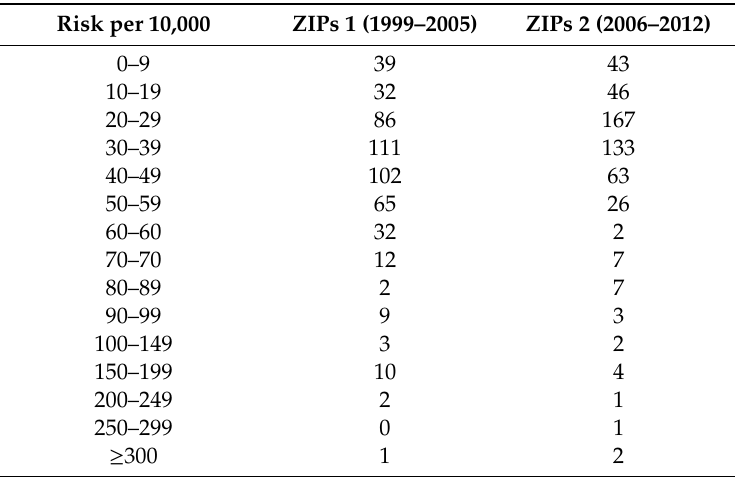
Table 2. Parkinson’s disease risks by Louisiana ZIP code areas.